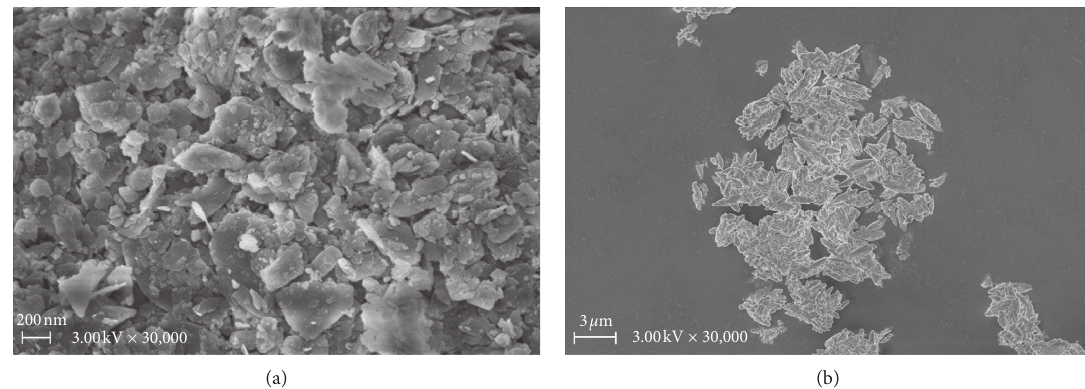
Figure 1: SEM images of (a) red clay and (b) precipitated calcium